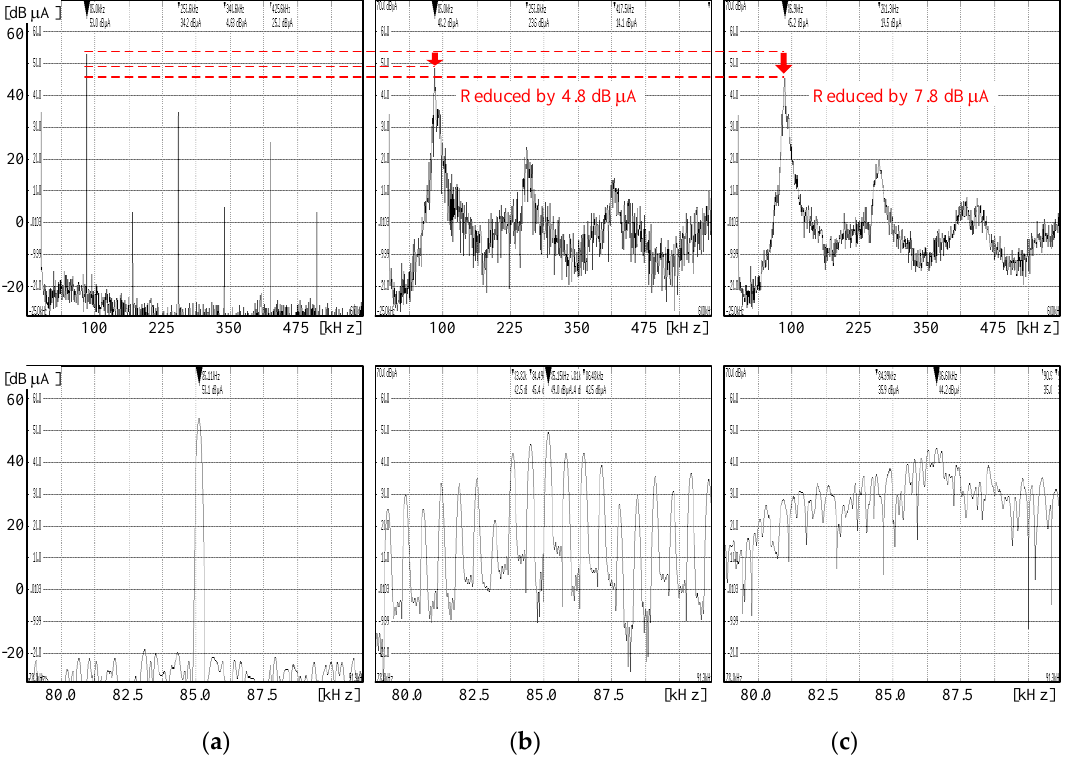
Figure 10. Radiation noise at measurement point A in y-z plane with SS compensation: ( a ) is the conventional method with constant frequency, ( b ) is the proposed method I: SSUD, and ( c ) is the proposed method II: SSBD.